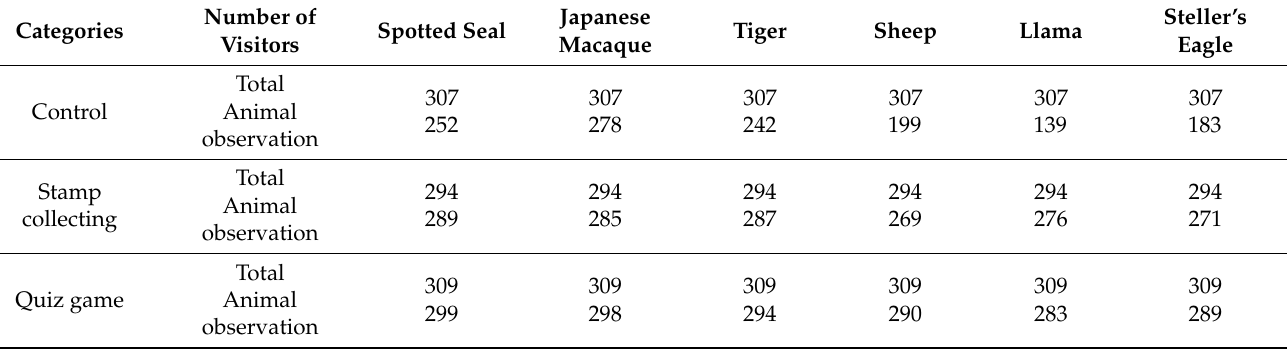
Table 1. Number of visitors who observed target species.